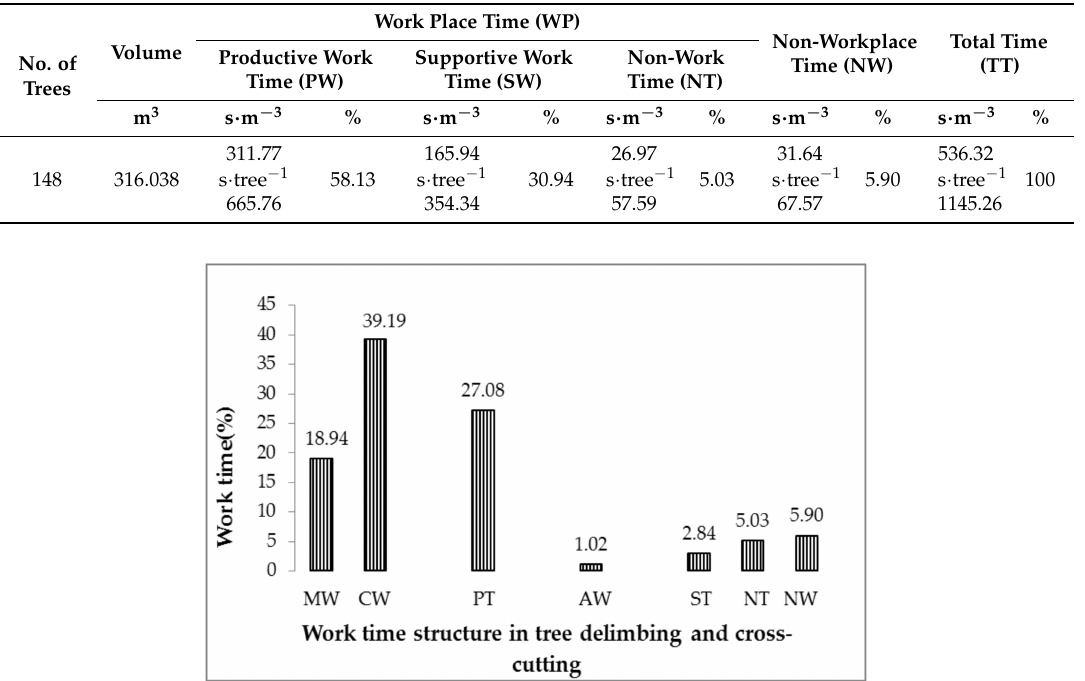
Table 4. Work time structure for delimbing and cross-cutting.